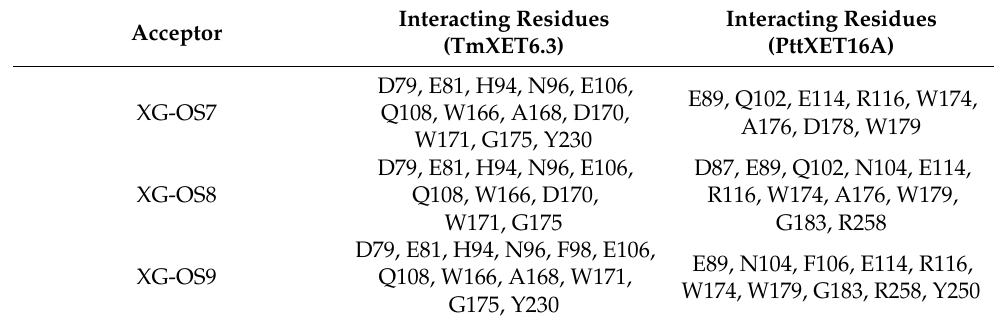
Table 2. The TmXET6.3 and PttXET16A residues that interact with XG-OS acceptors over 50% of MD simulation times at distances of up to 4.0 Å.